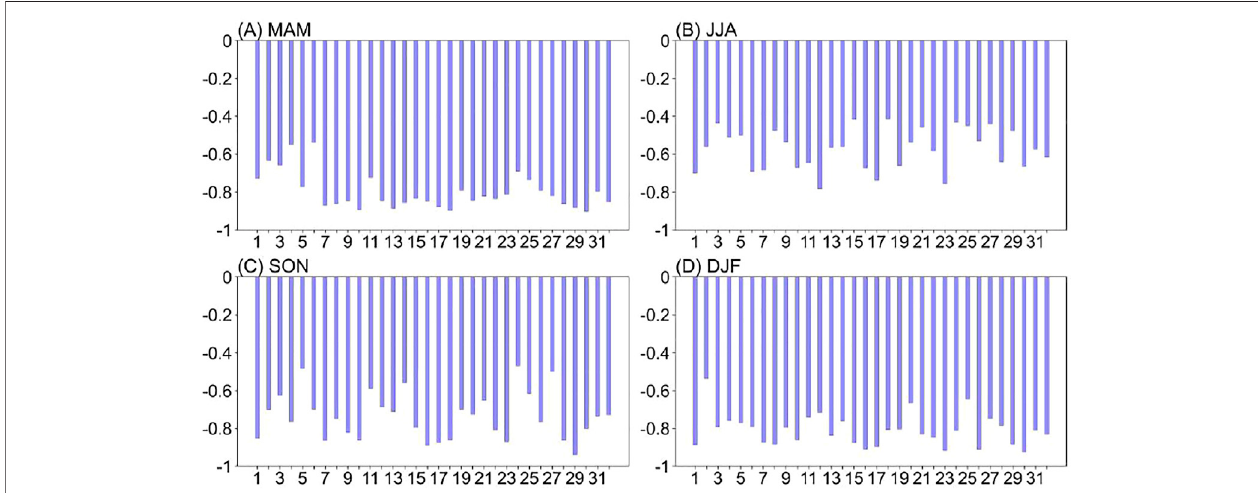
FIGURE4| AI-PIcorrelationsin (A) spring, (B) summer, (C) autumnand (D) winterduring1965 – 2014.Numbers1 – 30representtheindividualmodels(see Table1 for which model each number indicates). Number 31 and 32 represent MME and observation, respectively.